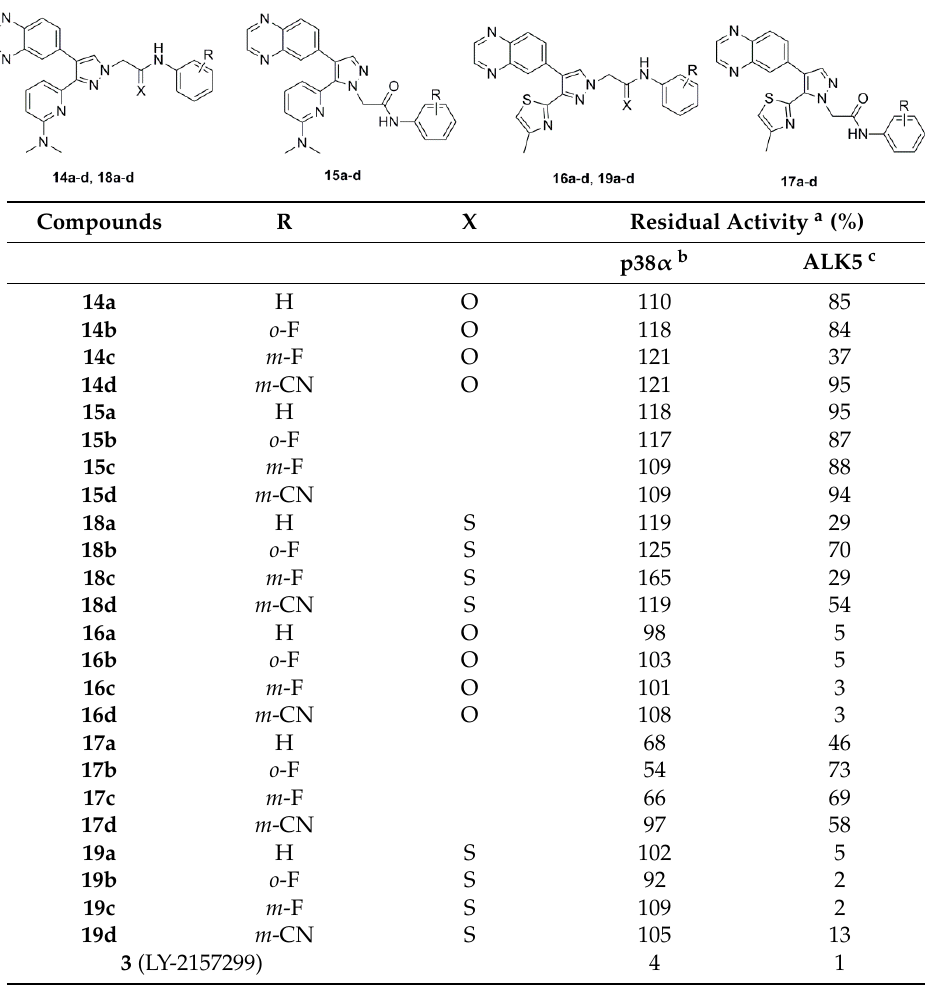
Table 1. Residual ALK5 and p38 α MAP kinase activities in the presence of Residual ALK5 and p38 α MAP kinase activities in the presence of